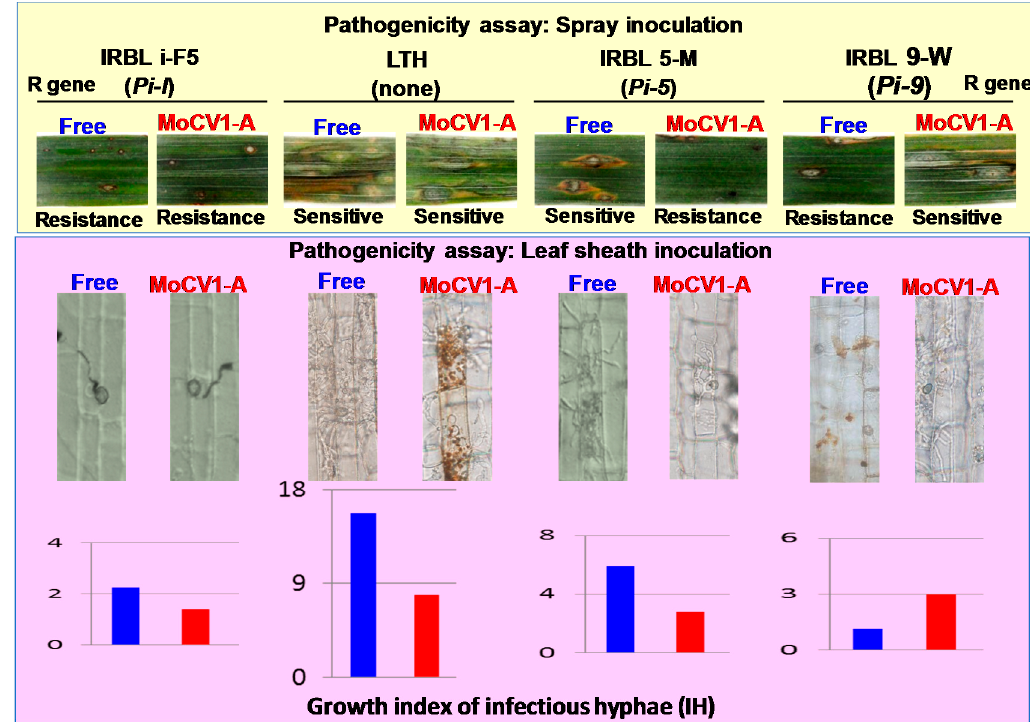
Figure 9. Influence of MoCV1-A on pathogenicity of M. oryzae . Upper panel: Spray inoculation assays revealed that MoCV1-A infection altered M. oryzae pathogenicity from virulence to avirulence (sensitive to resistance) in IRBL 5-M rice, and from avirulence to virulence (resistance to sensitive) in IRBL 9-W rice. Lower panel: The changes in pathogenicity were confirmed by changes in the growth indices of infectious hyphae in leaf sheath inoculation assays (lower panel). Details about the pathogenicity assays and statistical analyses are given in Aihara et al.